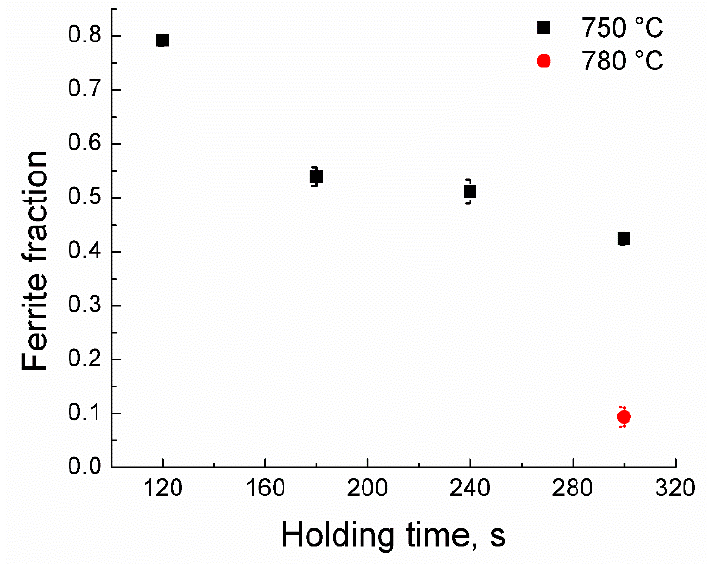
Figure 7. Effect of temperature and time on ferrite fraction during the intercritical annealing.